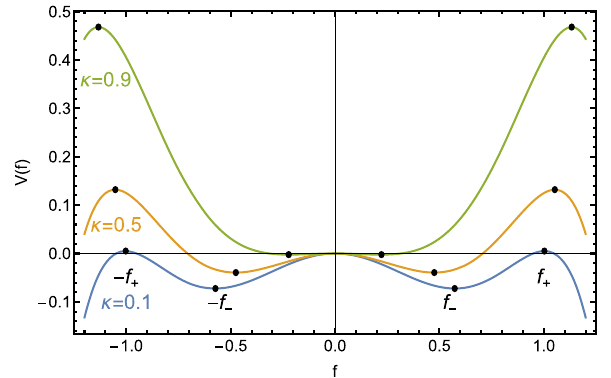
Fig. 1 Potential V ( f ) for κ = 0 . 1 (blue), κ = 0 . 5 (tan), and κ = 0 . 9 (green). The extrema ( ± ) f ± are shown as black